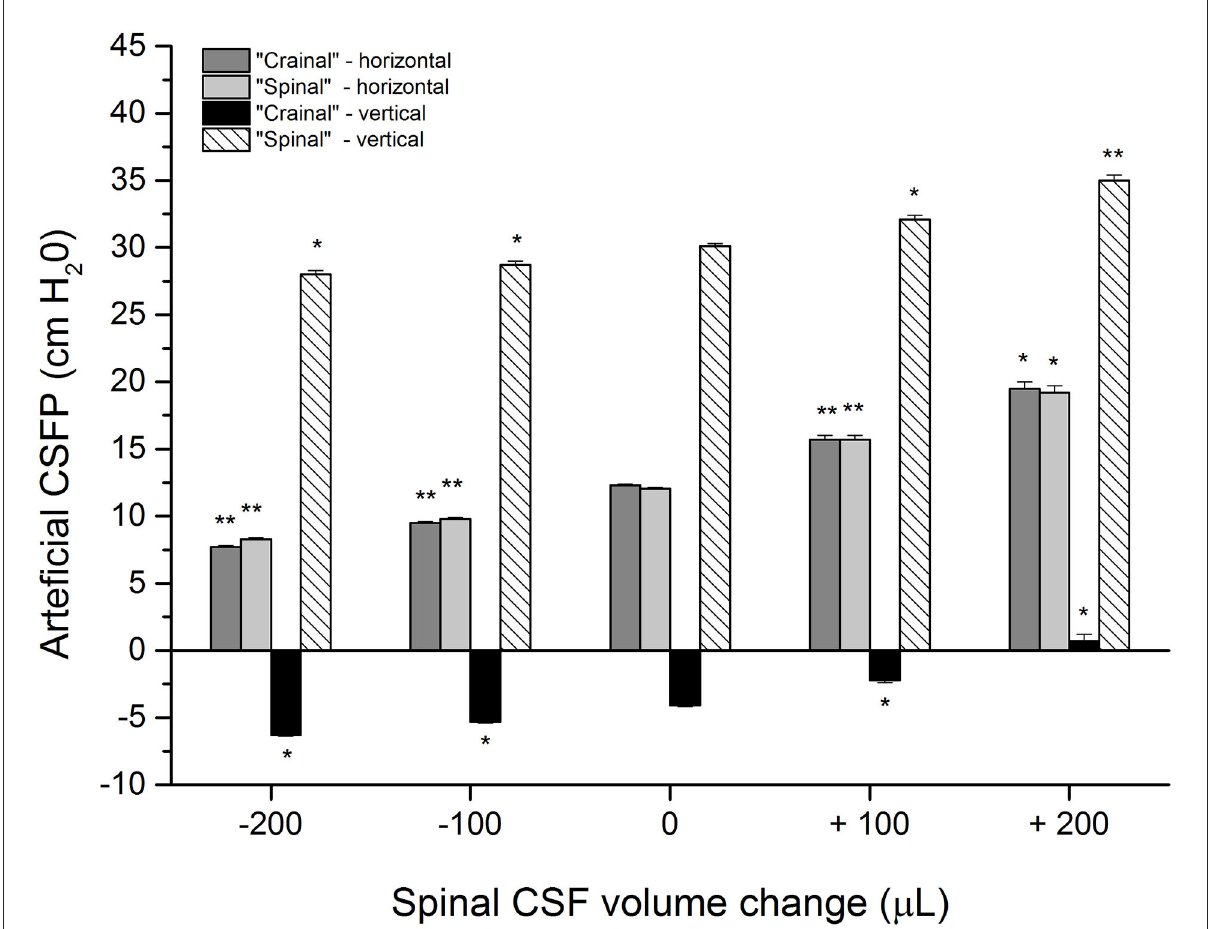
FIGURE3 Artificial CSFP changes (cm H 2 O) in the phantom in different positions: horizontal − 0 ◦ (“cranial”-horizontal; “spinal”-horizontal) and vertical-90 ◦ , inside the “cranial” and the “spinal” part of the phantom in the control condition (0 µ L; n = 5), after addition ( + ) of 100 and 200 µ L of artificial CSF into the “spinal” part (n = 5), and extraction (-) of 100 of 200 µ L from the “spinal” part ( n = 5). Columns represent the mean values of the measurements, and vertical lines represent standard errors of the mean values. There is a statistically significant difference between artificial CSF pressure in the control condition and after adding/removal of artificial CSF volume, * p < 0.05;** p <